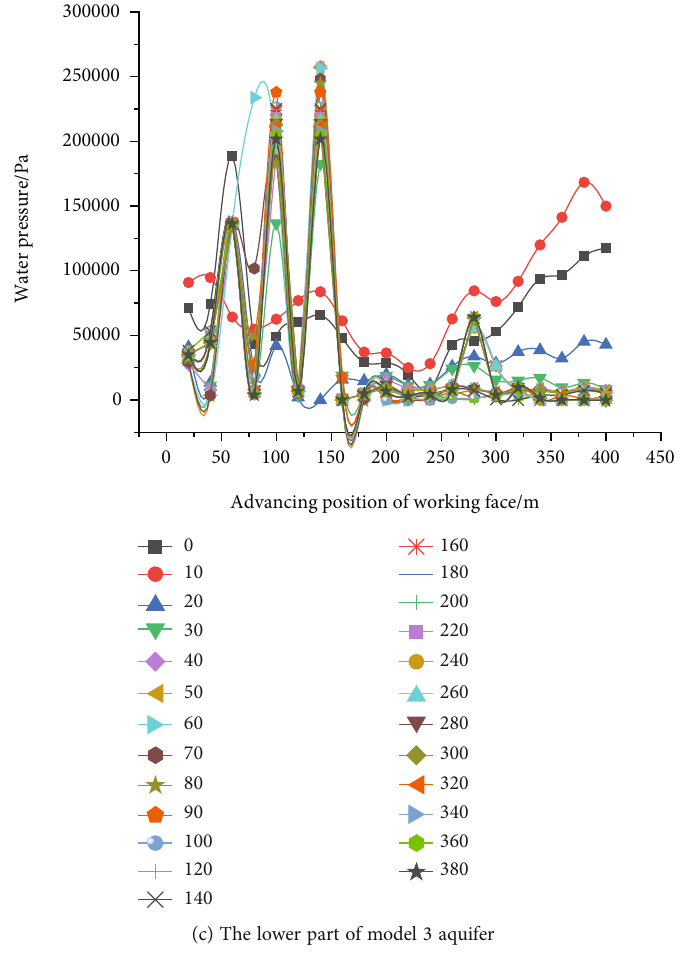
Figure 13: Variation law of water pressure in